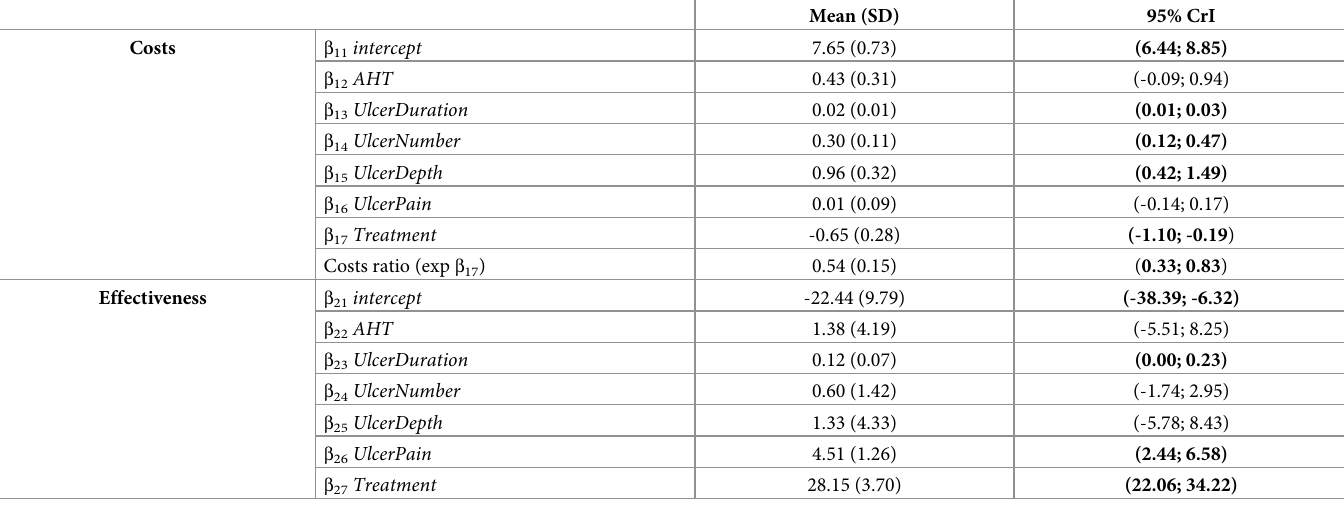
Table 5. Estimations of the posterior distribution of the β -coefficients for the cost-effectiveness analysis (100,000 simulations MCMC).